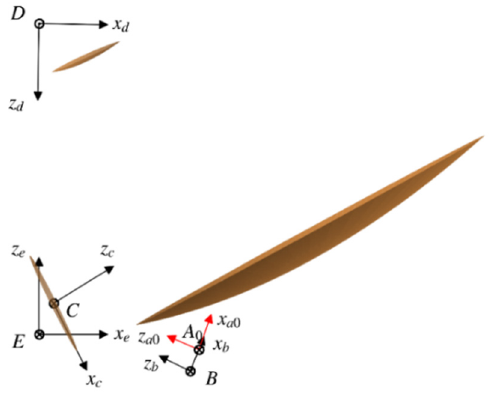
Figure 4. Definition of basic BFCSs that are used in deducing the ideal ABP determina- tion model.